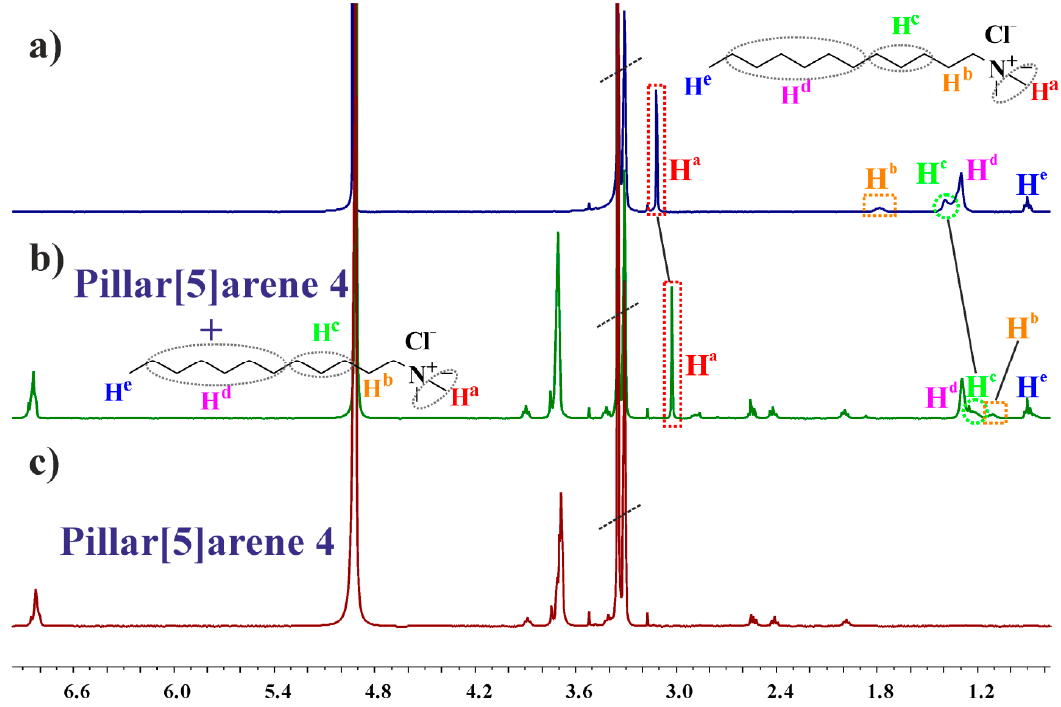
Figure 3. 1 H NMR spectra (MeOD- d 4 , 298 K, 400 MHz) of: ( a ) DTAC (0.005 mol/L); ( b ) 4 (0.005 mol/L) + DTAC (0.005 mol/L); ( c ) 4 (0.005 mol/L).